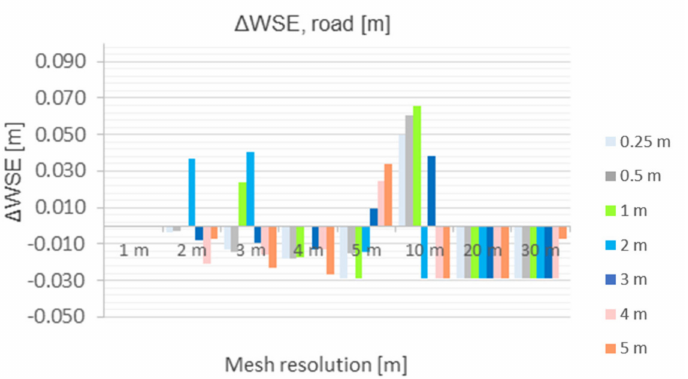
Figure 14. Overview of results of ∆ WSE at the control point on the road for the different mesh and DEM resolutions (DEM: colored